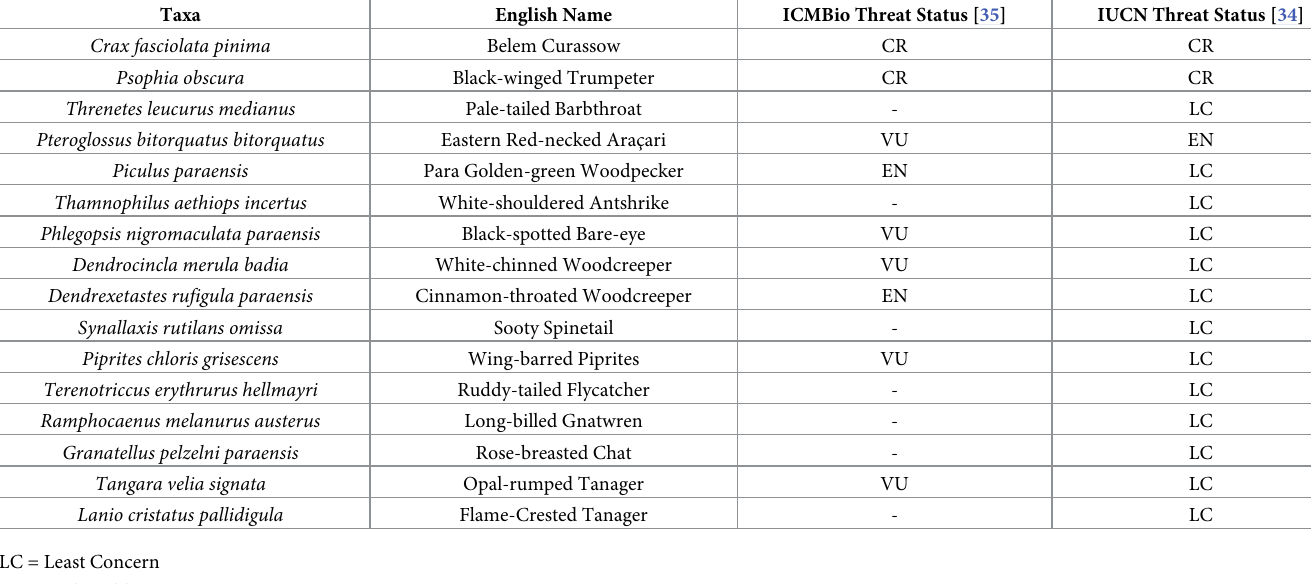
Table 1. List of endemic species and subspecies occurring in the Bele´m area of